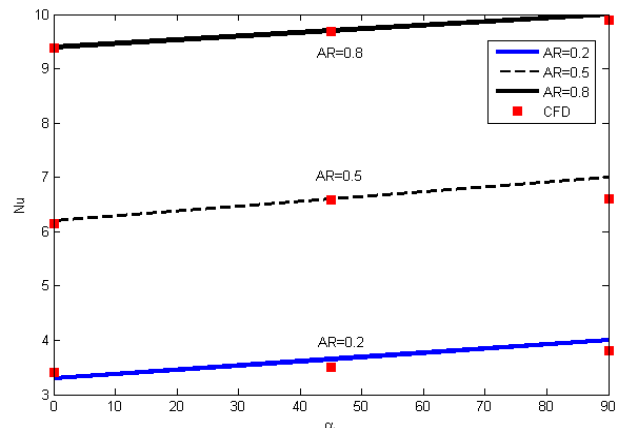
Figure 7. Examining the Nusselt number relative to the angle of the chamber at ϕ = 0.05, Ha = 0, and Ra = 10 6 .